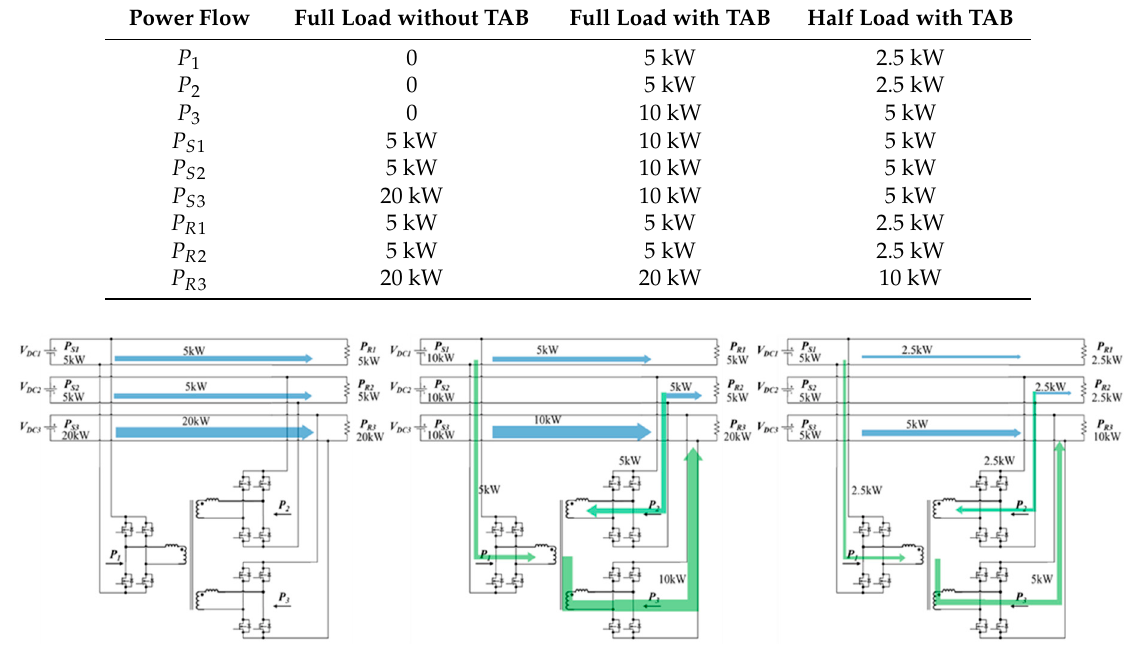
Table 1. Parameters of the 380-V TAB converter used in the DC power distribution system. Table 2. Simulation parameters for the 380-V TAB converter used in the DC power distribution system.